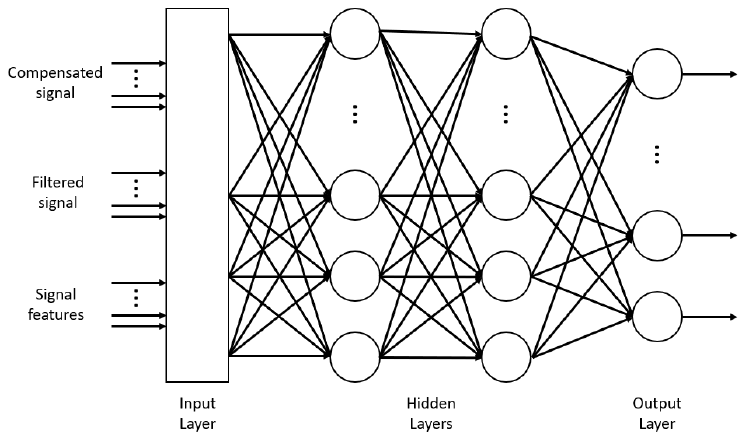
Figure 11. ANN diagram of the CEMF algorithm.